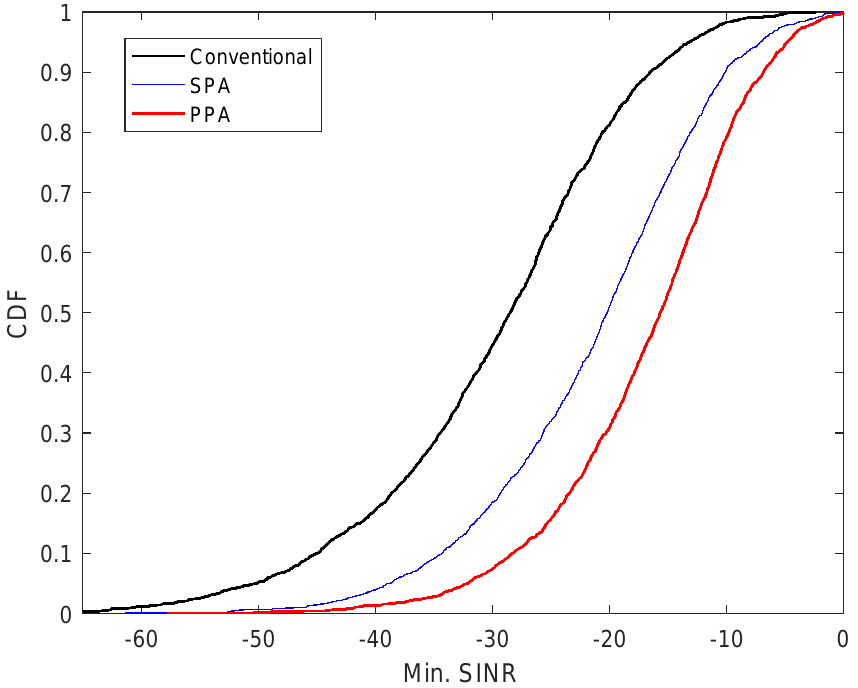
Figure 10. CDF of the minimum SINR per user when M=64 using an MRC